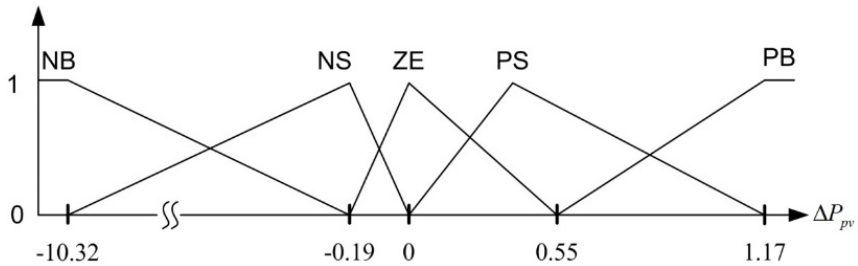
Figure 12. The obtained optimal MF setting.